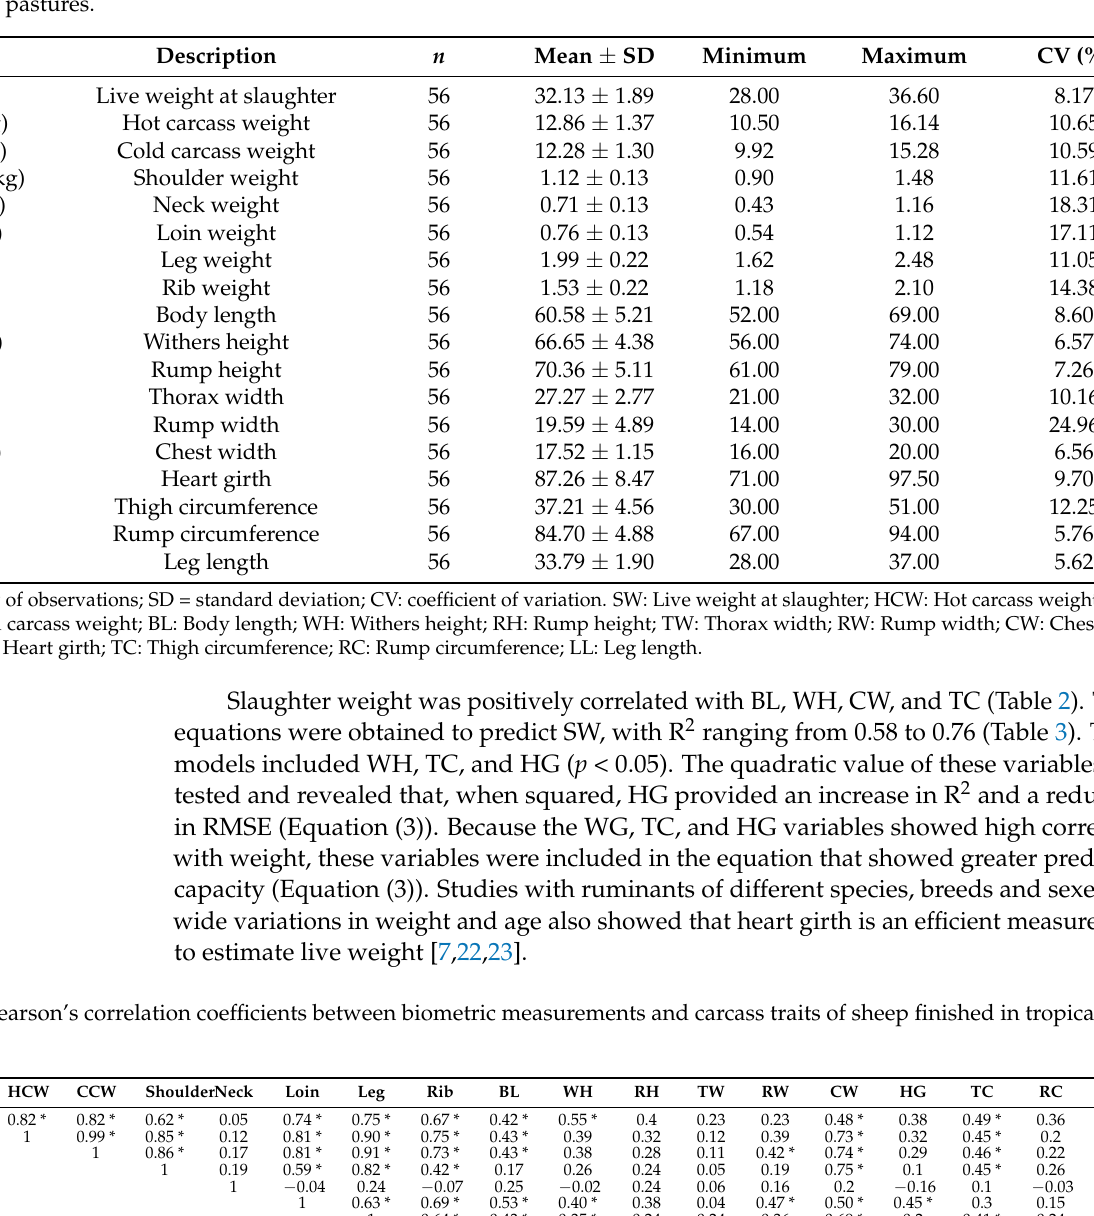
Table 1. Summarized descriptive statistics of the parameters obtained in vivo and on the carcass of wool-less sheep finished in tropical pastures.